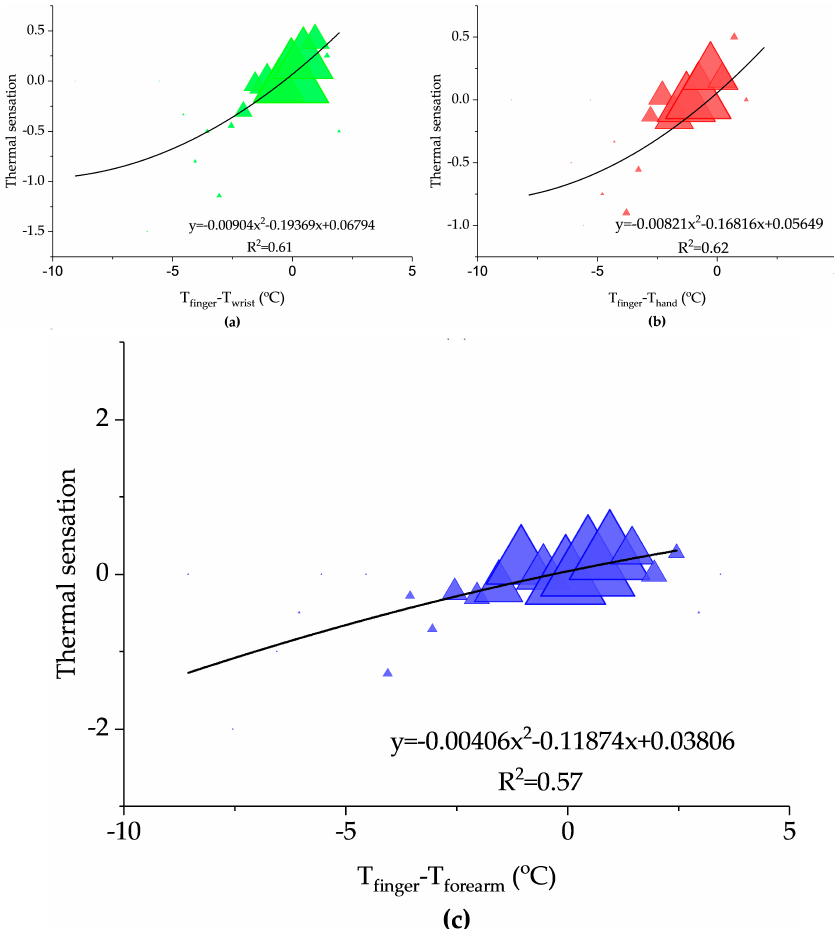
Figure 9. Relationships between the gradients of extremity skin temperatures and thermal sensation: ( a ) Thermal sensation vs. T finger-wrist ( b ) Thermal sensation vs. T finger-hand ( c ) Thermal sensation vs. T finger-forearm